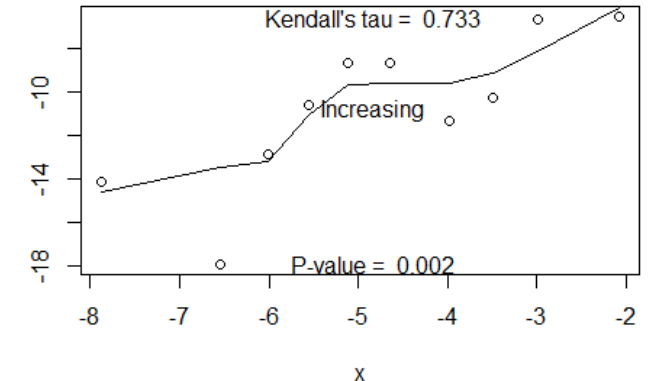
Figure 4. The LOWLESS plot based on the treatment effect estimates on the SBP ( y ) and those on the DBP ( x ) from the blood pressure dataset with 10 studies. Shown are Kendall’s tau and the test of no association between x and y .